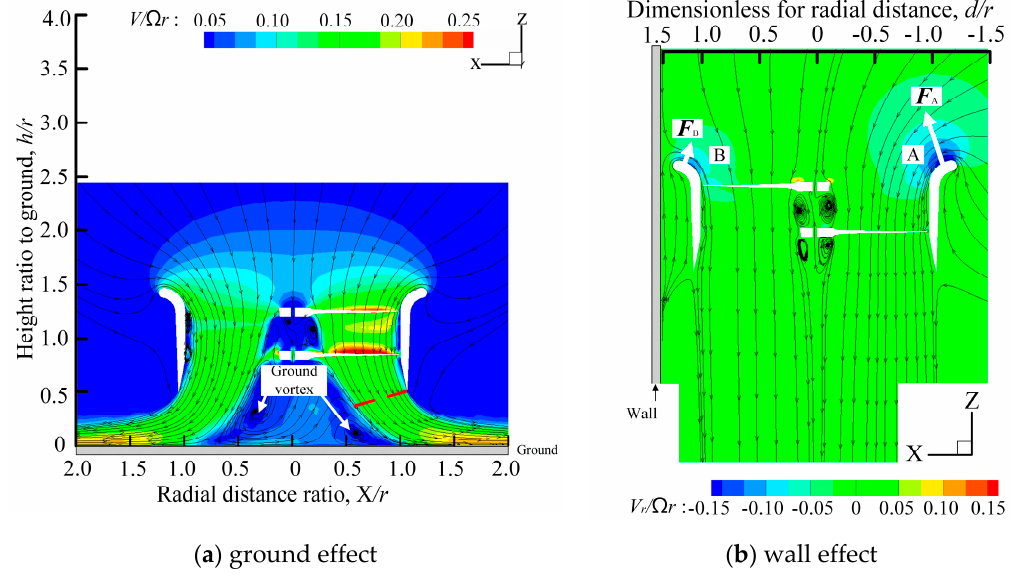
Figure 3. Velocity cloud of ducted fan with ground effect or wall effect.